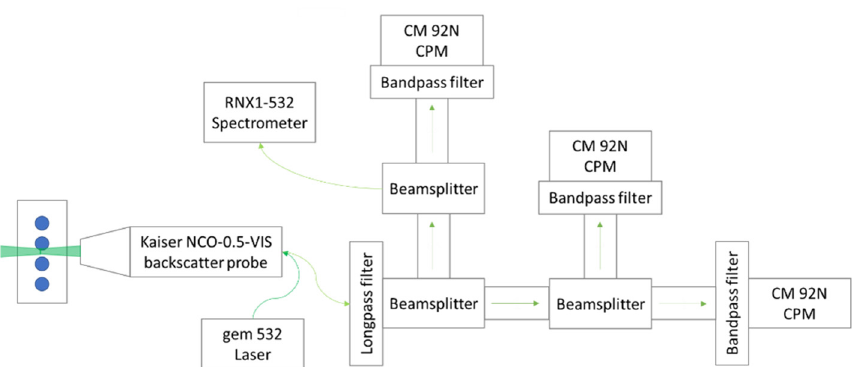
Figure 1. Schematic illustration of the measurement system. The focus is on the measurement technology components; details of the emulsification technology are not included [38].